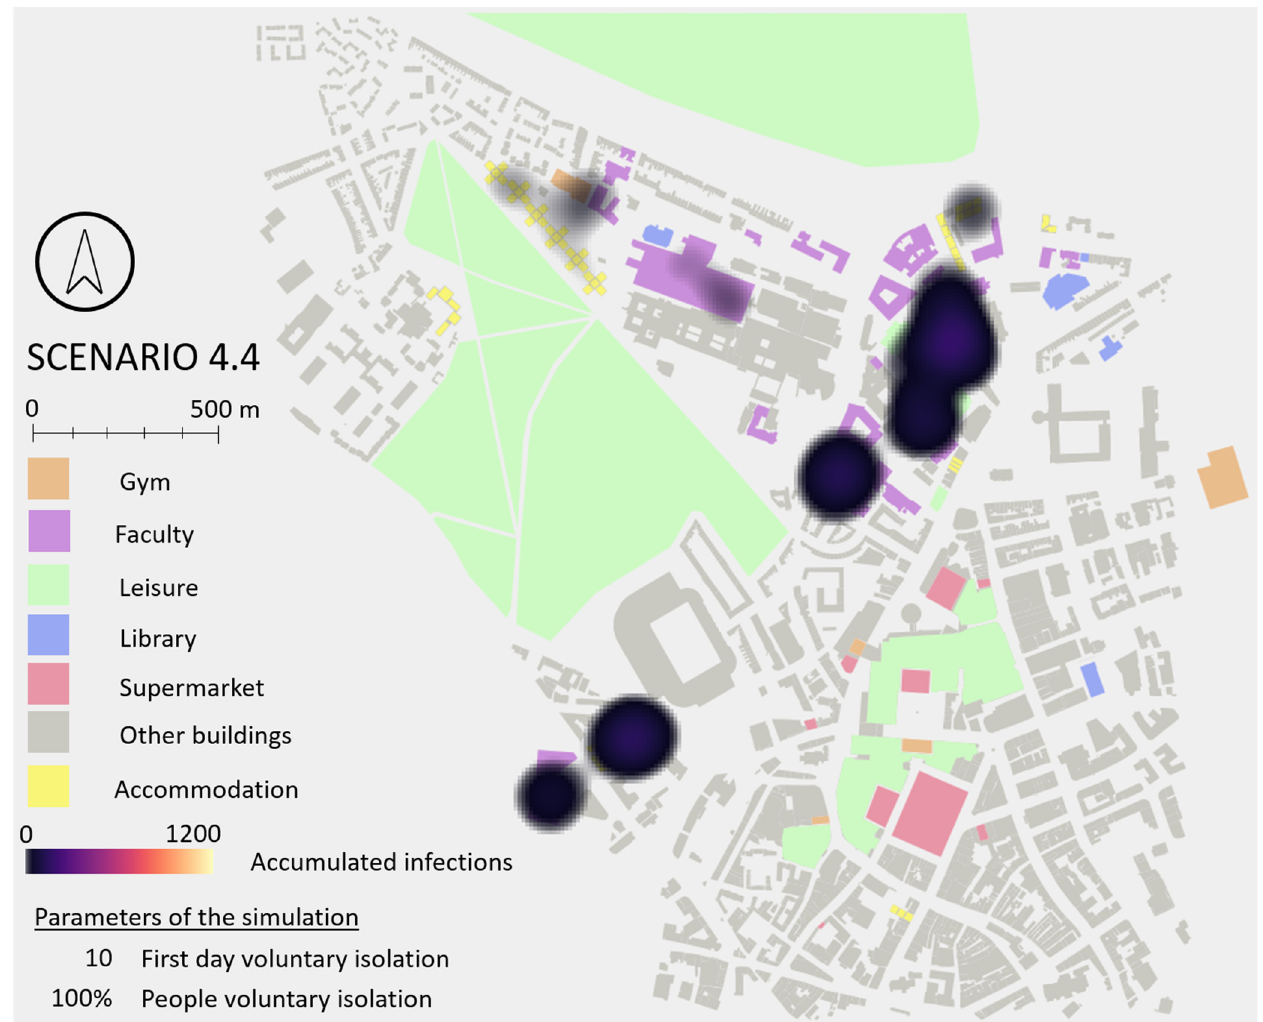
Figure A8. Heat map for Scenario 4.4 (100% students self-isolated from Day 10) showing the areas (in light yellow) where more infections were produced. Weak infection areas were found in the study area. As a consequence of self-isolation measure, 86% of students remained susceptible and therefore case numbers (and densities) were much lower. © Crown copyright and database right 2020.